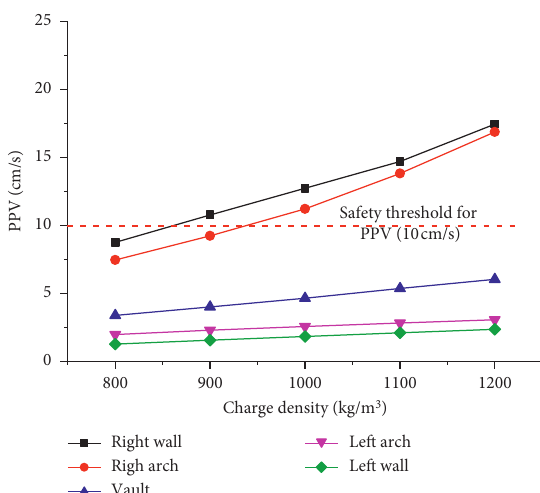
Figure 15: Changes of maximum PPV with charge density.